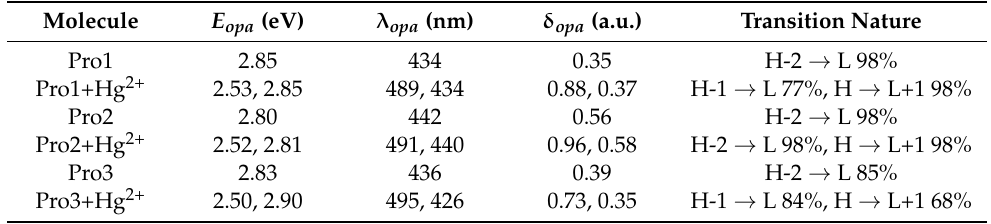
Table 1. One-photon absorption properties, including the excitation energy E opa (eV), the corresponding wavelength λ opa (nm), the oscillator strength δ opa (a.u.), and the transition nature for Pro1, Pro1+Hg 2+ , Pro2, Pro2+Hg 2+ , Pro3 and Pro3+Hg 2+ in H 2 O. H (L) denotes the HOMO (LUMO). Molecule E opa (eV) λ opa (nm) δ opa